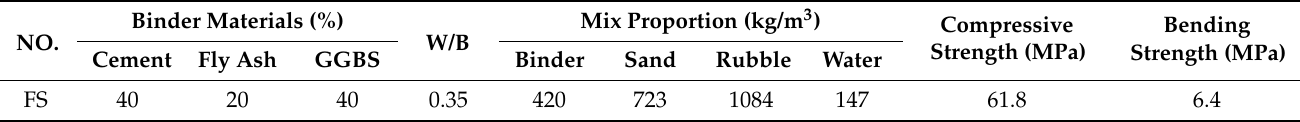
Table 2. Mix proportion and 28 d mechanical properties of concrete C50.